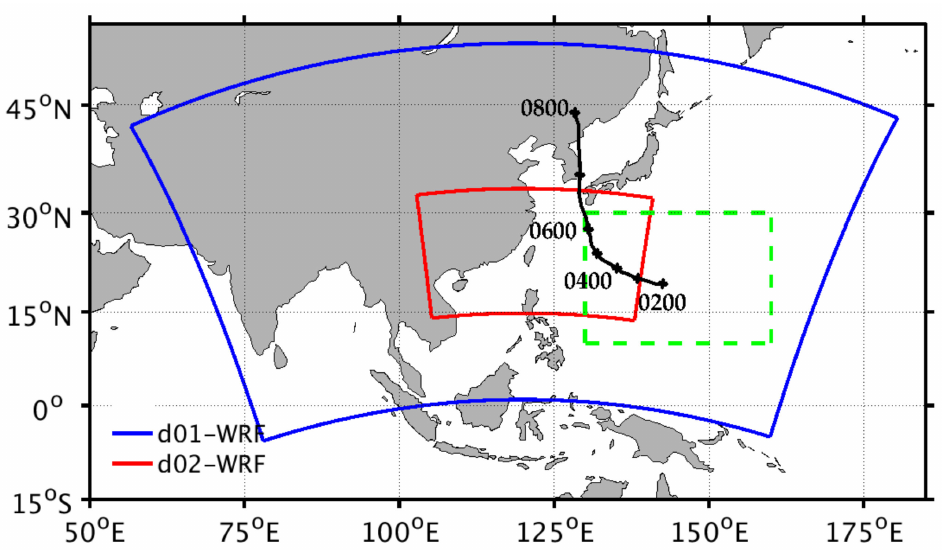
Figure 1. The model domains with 15-km and 3-km resolutions for the outermost domain (blue) and the inner domain (red), respectively. The best track of Typhoon Haishen (2020) from JMA is indicated by the black line with plus symbols at a 6-h interval. The green dashed box indicates the region for forecast